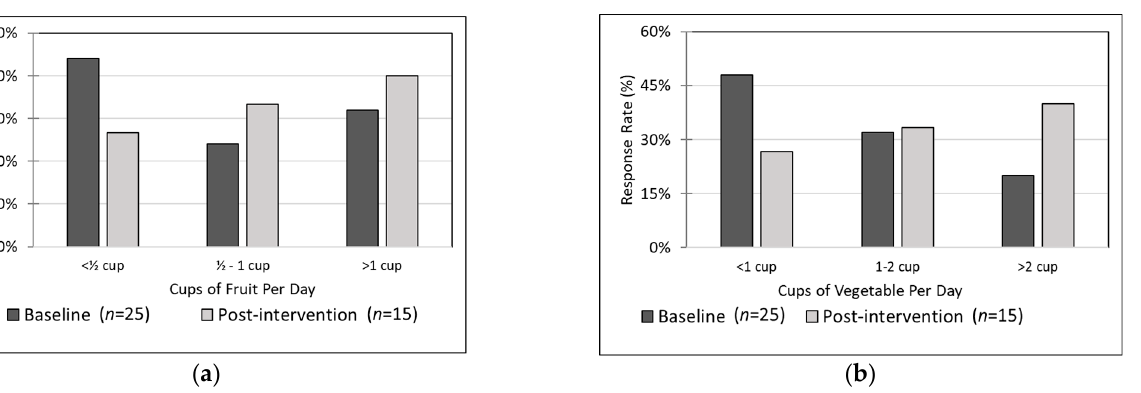
Figure 3. Adult fruit and vegetable intake. Distribution of adult fruit and vegetable intake at baseline ( n = 25) and post-intervention ( n = 15). ( a ) Adult fruit intake (chi-square p = 0.32). ( b ) Adult vegetable intake (chi-square p = 0.07).